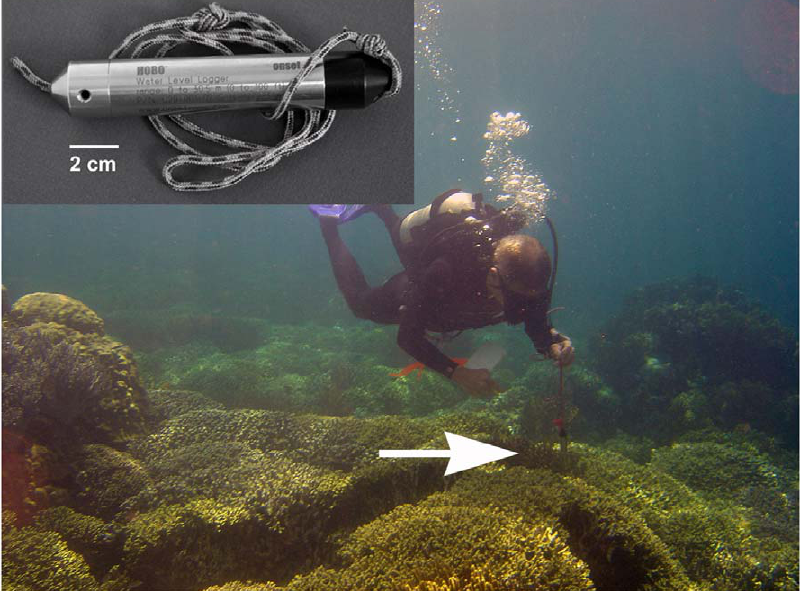
Figure 2. Diver demonstrates DRR methodology with inset showing level gauge. Digital Rugosity measurements are accomplished by using the instrument as a plumb-bob to slowly follow the contour of the reef as closely as possible. The pressure transducer is located near the end of the instrument closest to the substrate. The recorded pressure depth is offset from the actual reef substrate depth by the distance between the transducer and the substrate (photo A Alling).